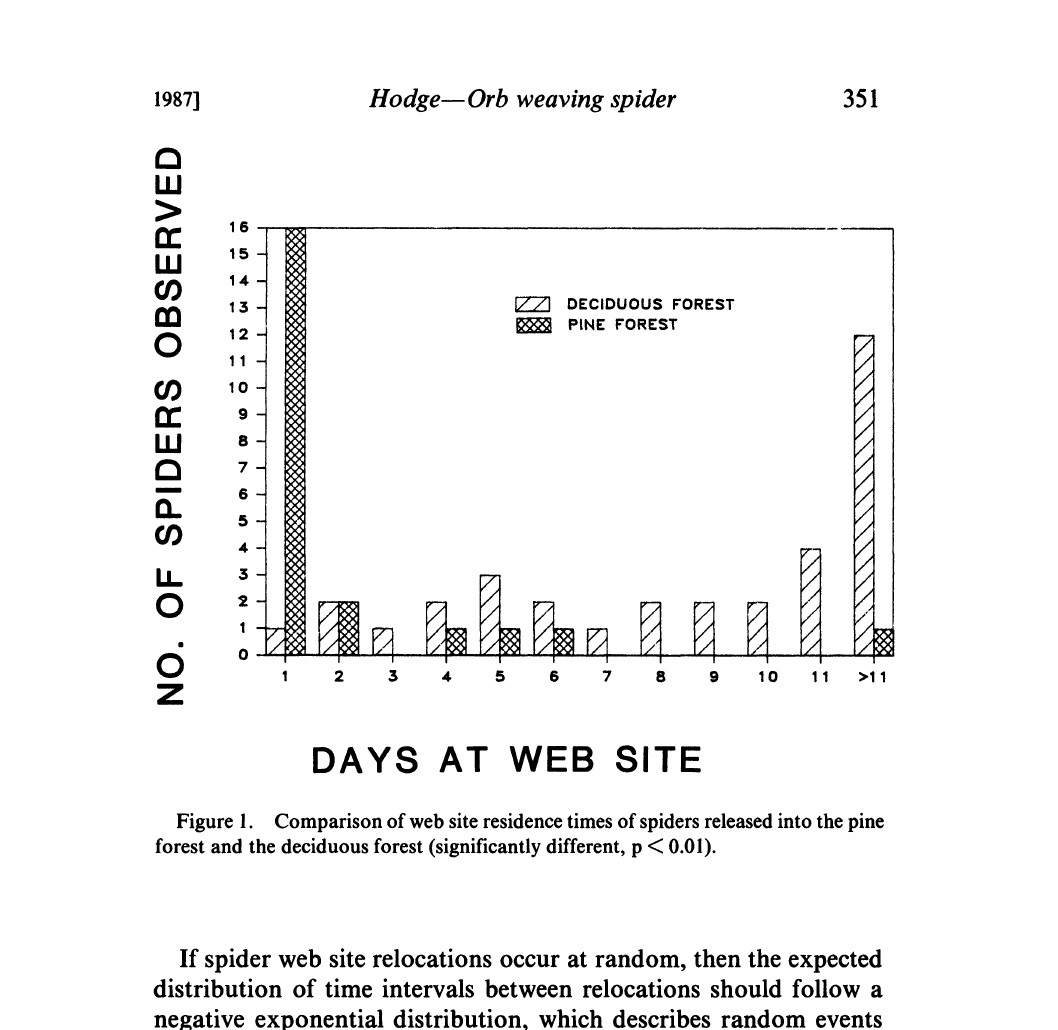
Figure 1. Comparison of web site residence times of spiders released into the pine forest and the deciduous forest (significantly different, p <